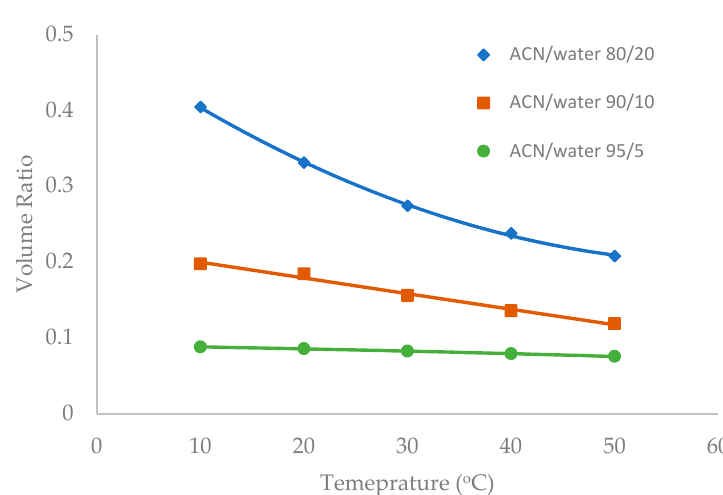
ratio in all the mobile phase conditions, indicating that the water-rich liquid layer is reduced at higher